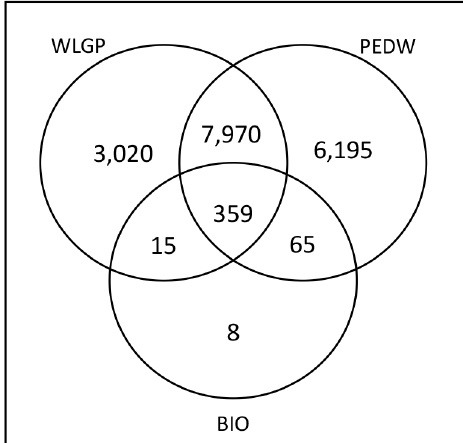
Figure 2: Numbers of patients in the UC cohort identified from each of the available data sources after those also diagnosed with Crohn’s Disease had been